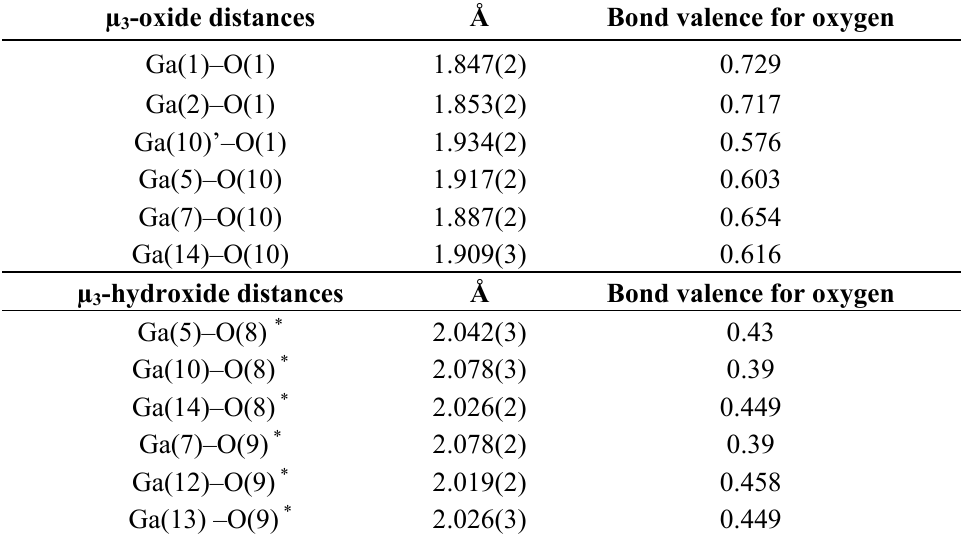
Table 1. The distinction between the μ 3 - oxo and μ 3 -OH is possible because of the associated Ga-O